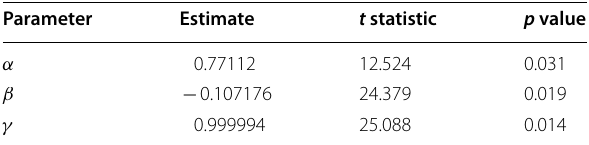
Table 1 The parameter estimates of the log linear